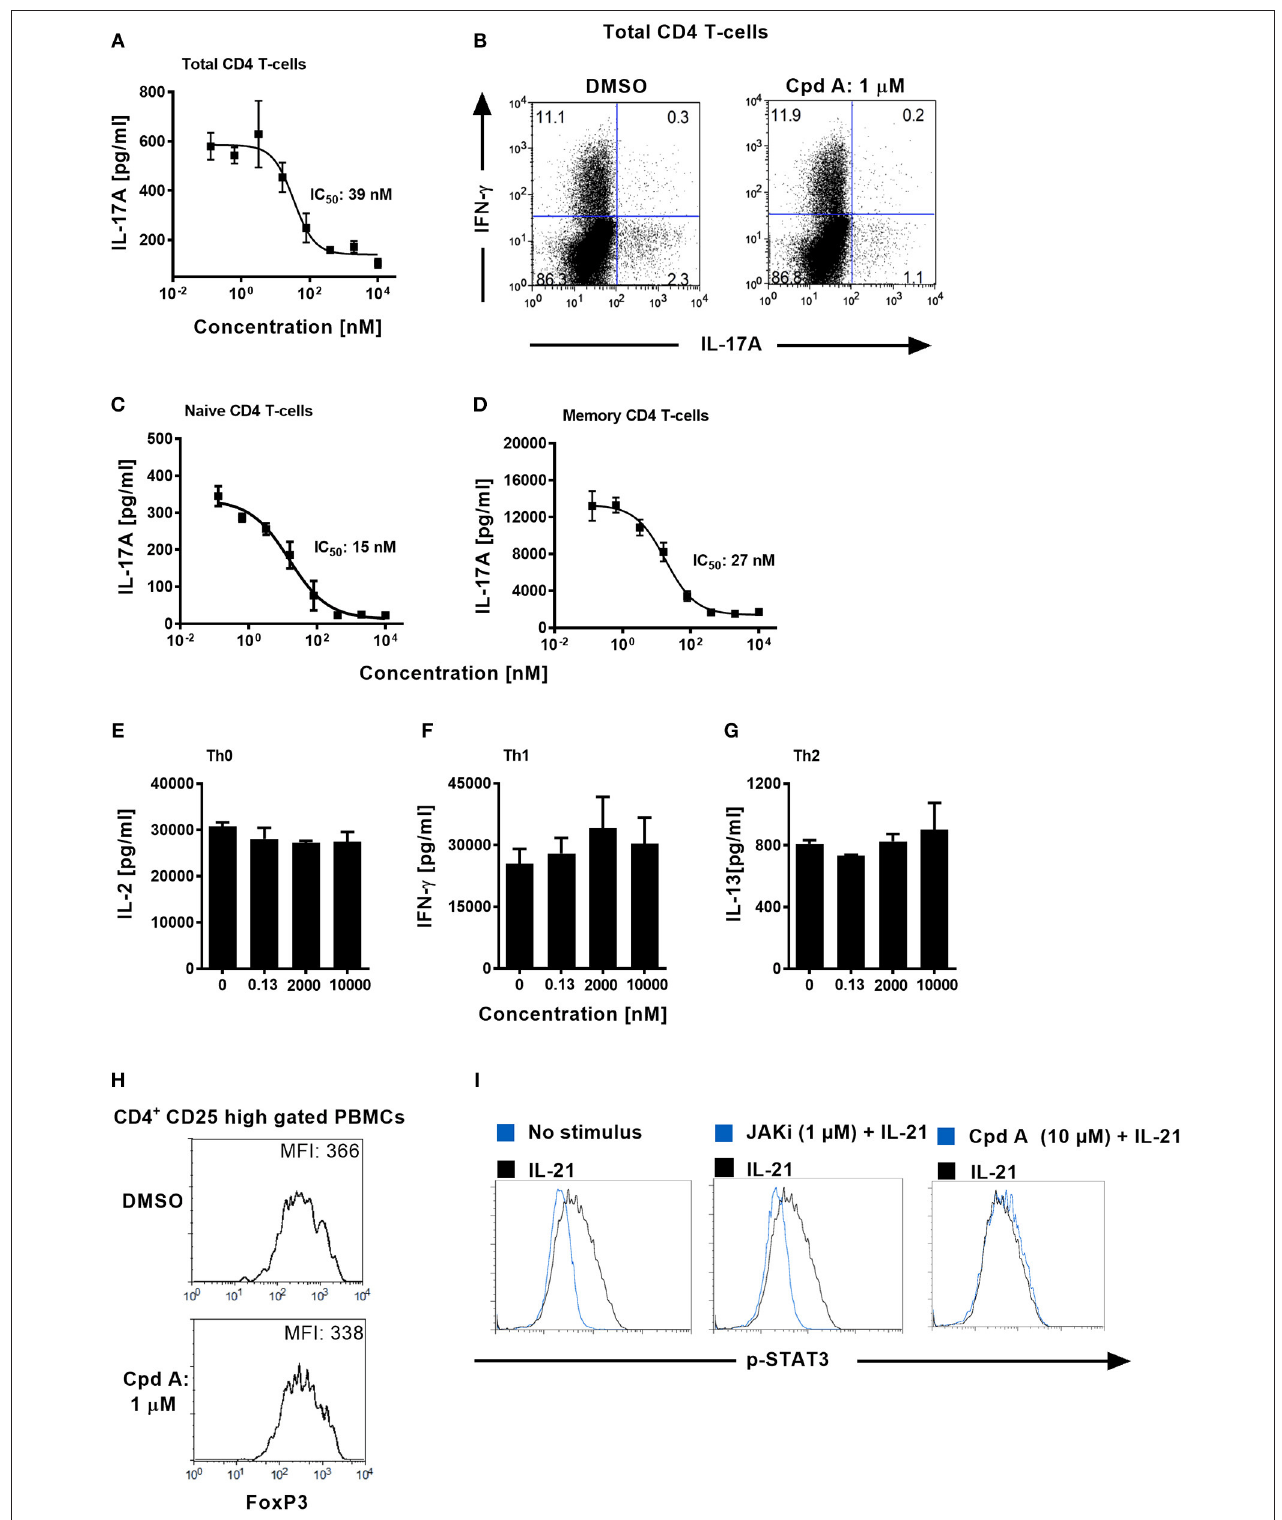
FIGURE 3 | Cpd A specifically blocks human Th17 cell polarization, while leaving Th0, Th1, or Th2 T-cell polarization, STAT3 phosphorylation and FoxP3 expression intact. (A) Total human CD4 + T-cells were isolated from buffy coats and were polarized toward the Th17 phenotype for 72h in the presence of the ROR γ t inhibitor